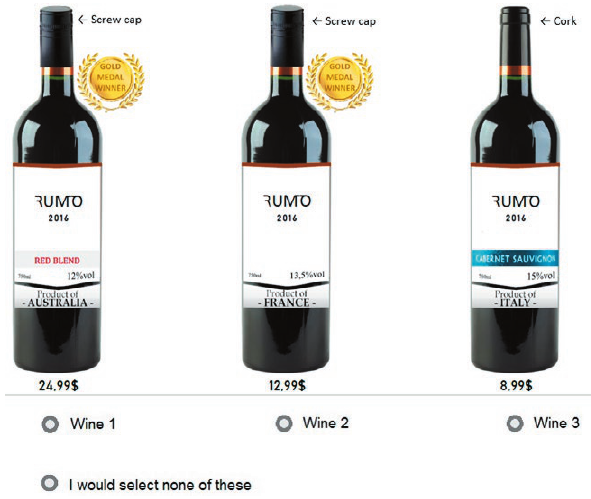
Figure 2. Example of a choice